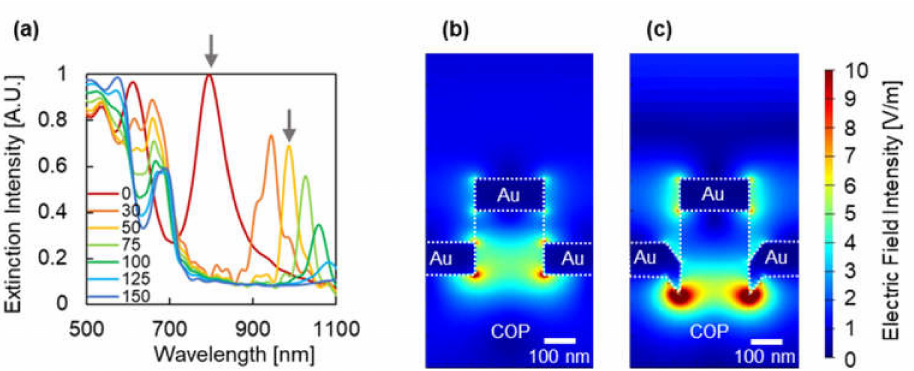
Figure 6. ( a ) Simulated spectra of plasmonic devices with different pit depths while the diameter is fixed at 190 nm. The chart series in the graphs indicate the pit depth (nm). Cross-sectional electric field distribution of plasmonic devices with a different pit depth of ( b ) 0 nm at the 610 nm wavelength are pointed out in Figure 6a by the left gray arrow, and ( c ) the 50 nm and at 985 nm wavelength pointed out in Figure 6a by the right gray